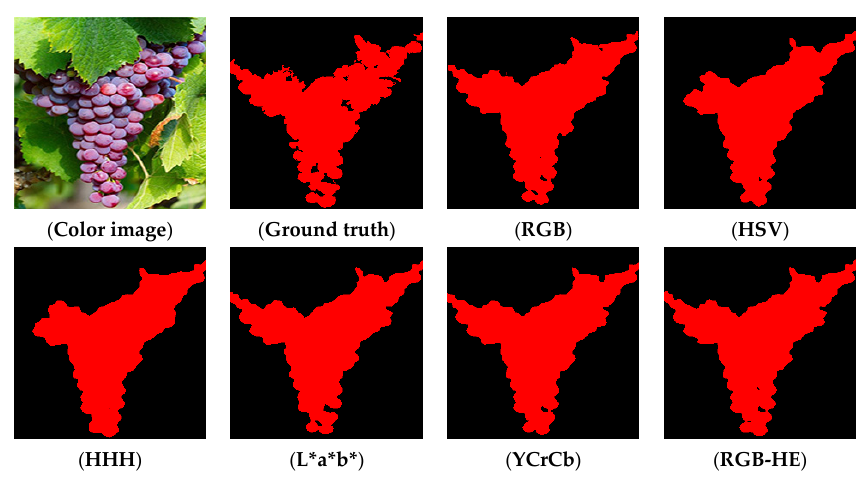
Figure 7. Visualization of pixel-wise segmentation results of different datasets. Table 5. Performance of different input representations.